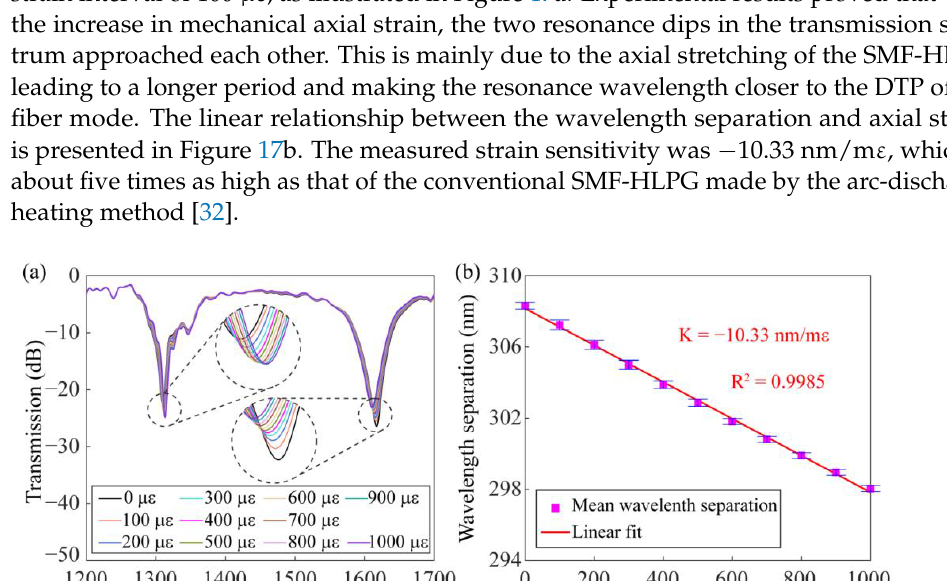
Table 1. Comparison of the dual-resonance SMF-HLPG with different studies. Struc- ture